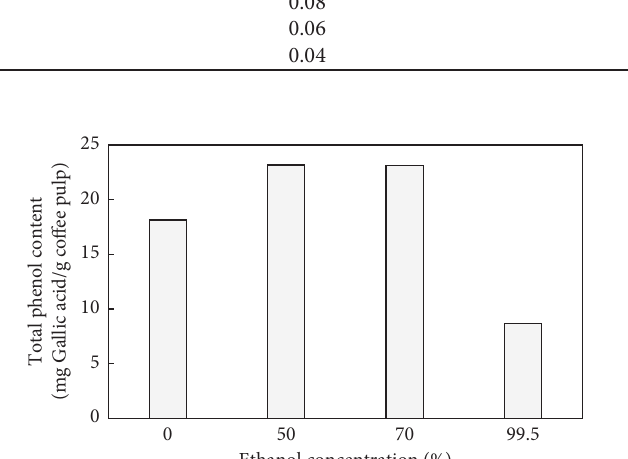
Figure 2: Total phenolic content of the coffee pulp extracts obtained using different ethanol concentrations.